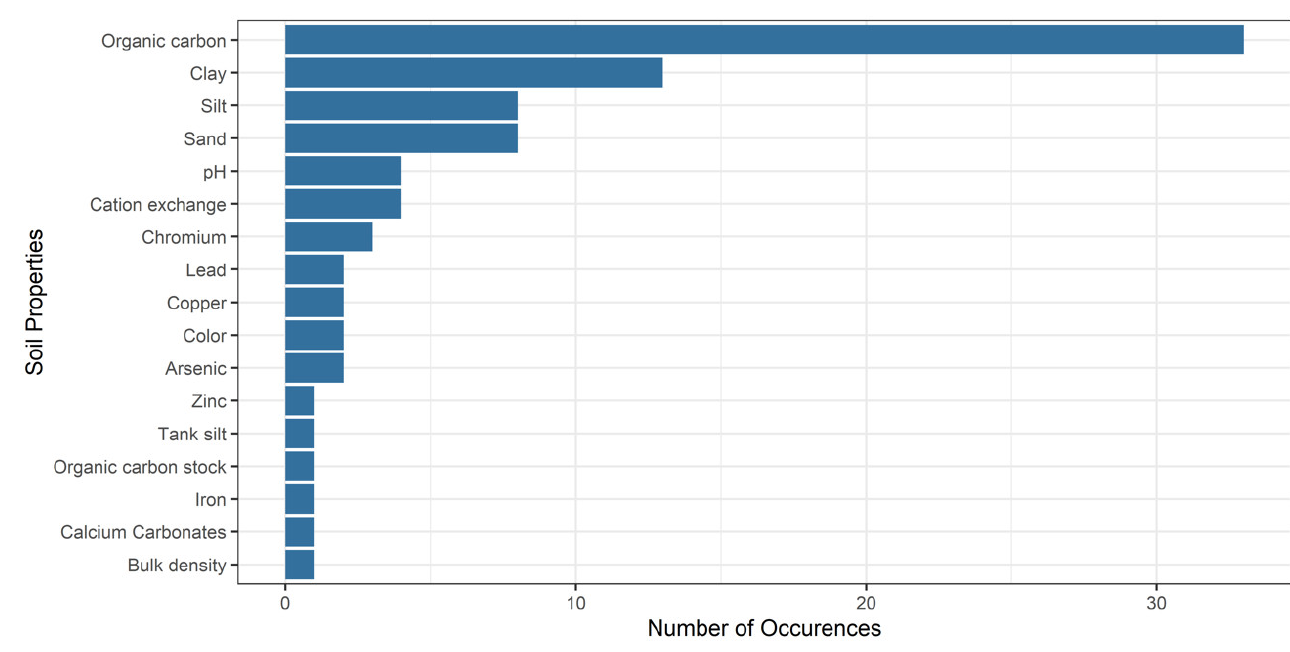
Figure 3. Overview of the most important estimated soil properties taken into account by the studies included in this review. Organic matter is displayed together with organic carbon.